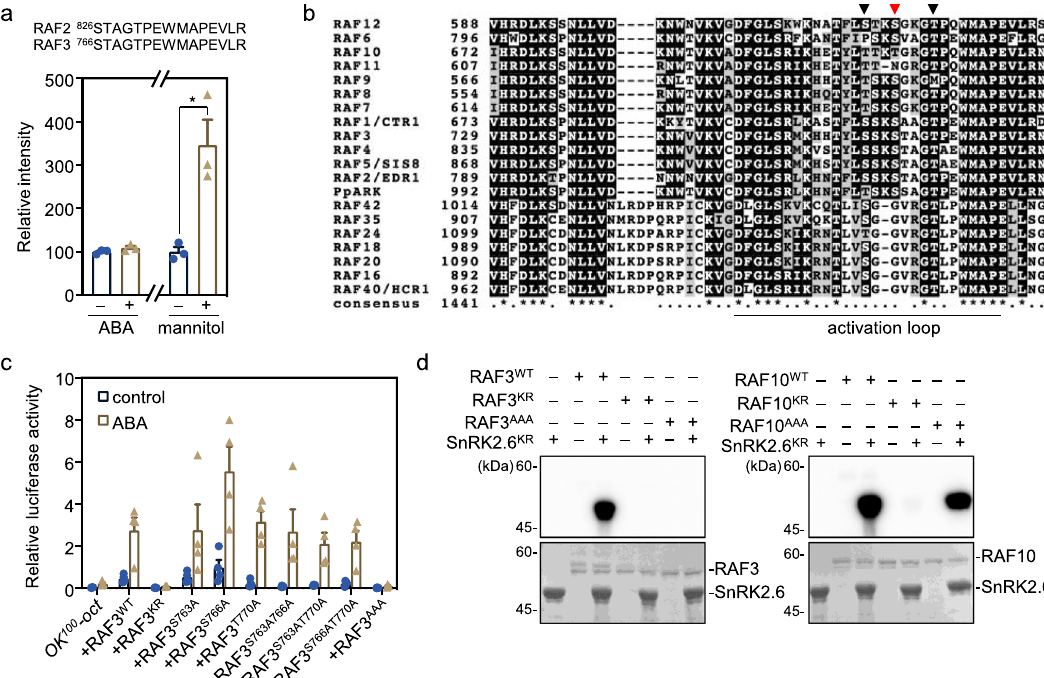
Fig. 6 ABA does not activate B2 and B3 RAFs in plants. a The phosphorylation of the conserved phosphosite in RAF2 and RAF3 showing enhanced phosphorylation by mannitol but not ABA treatment. The relative intensity of the phosphopeptide was obtained from previous phosphoproteomics results ( n = 3 biological replicates). b Sequence alignment showing the conserved phosphosites (indicated by arrows) in the activation loop of Arabidopsis B2, B3, B4 RAFs, and PpARK/PpCTR1 from Physcomitrella patens . The conserved serine residues corresponding to Ser1029 in PpARK/PpCTR1 are highlighted by the red arrow. c Activation of the reporter gene by wild type and the non-phosphorylatable mutants of Ser763, Ser766, and Thr770 in RAF3 in transient reporter gene expression in protoplasts of OK 100 -oct . RAF3 K636R (RAF3 KR ), a kinase-dead form of RAF3, is used as a control. Error bars, SEM ( n = 3 individual transfections). d Phosphorylation of SnRK2.6 KR by recombinant kinase domain of RAF3 and RAF10. Wild type and mutated recombinant GST- RAF3-KD (left panel) and GST-RAF10-KD (right panel) was used to determine the phosphorylation of SnRK2.6 KR expressed and puri fi ed from E. coli in the presence of [ γ - 32 P]ATP. GST-RAF3 K636R (RAF3 KR ) and GST-RAF10 K515R (RAF10 KR ) were used as negative controls. Autoradiograph (upper) and Coomassie staining (lower) show phosphorylation and loading, respectively, of puri fi ed GST-RAF3-KD, GST-RAF10-KD, and HIS-SnRK2.6 KR . Images shown are representative of at least two independent experiments. Source data are provided in Source